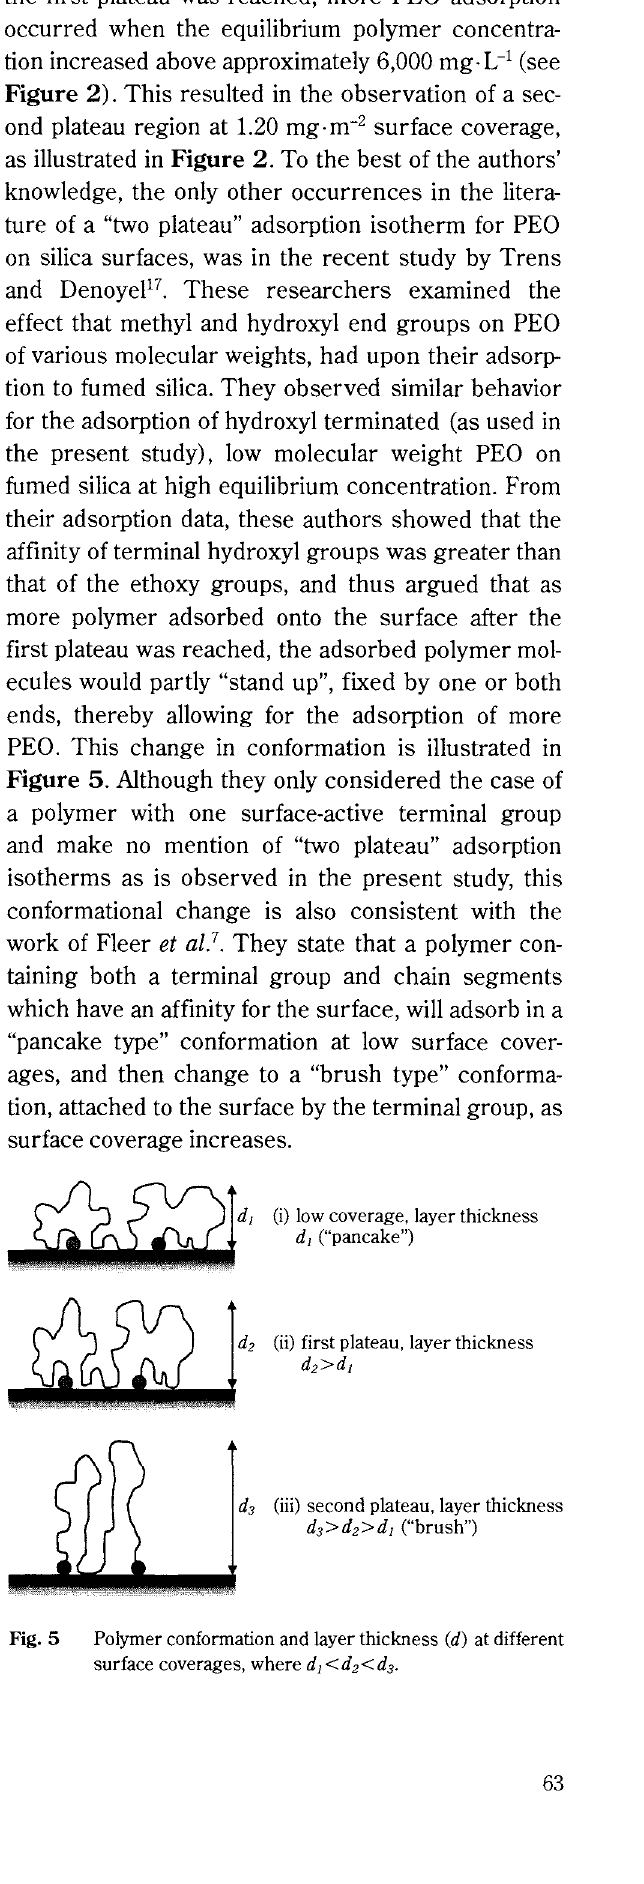
r max. Radius of Gyration (R~), and Experimental and Theoretical Parking Areas (Stheocy) for 7,500 MW PEO on 50 %vol Fraction of 0.60 !lm Silica Particles. Plateau first second